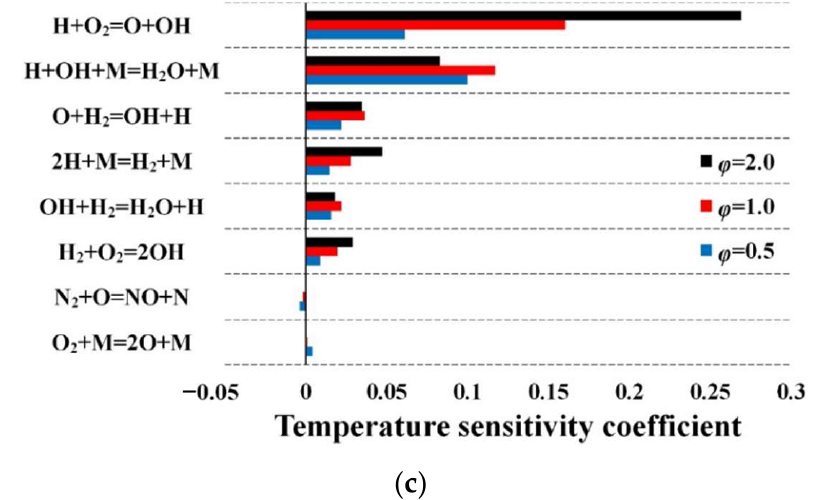
Figure 8. Sensitivity analysis under different temperatures, pressures, and equivalence ratios. ( a ) Equivalence ratio of 1.0, pressure of 1 atm. ( b ) Equivalence ratio of 1.0, temperature of 1500 K. ( c ) Pressure of 1 atm, temperature of 1500 K.